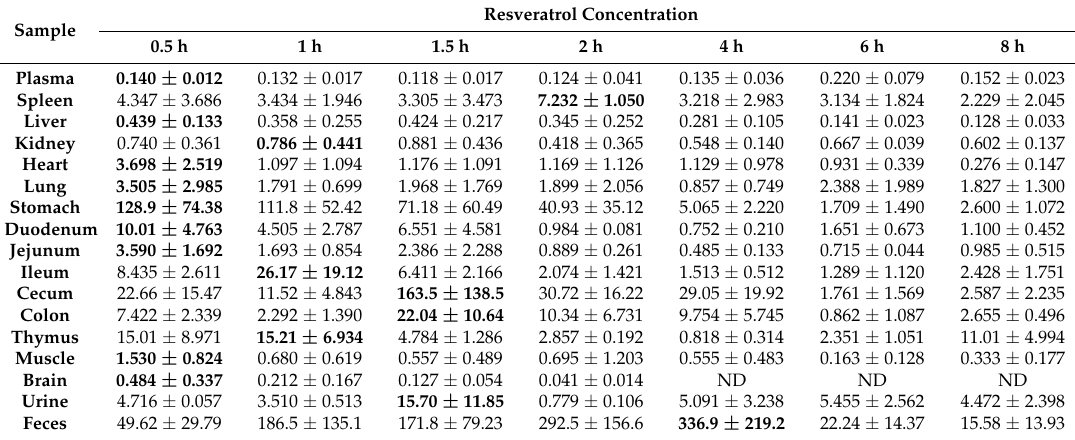
Table 1. Distribution of unmetabolized resveratrol in plasma (nmol/mL), various organs (nmol/g of tissue), urine (nmol/mL), and feces (nmol/g wet content) of mice at different time-points following the intragastric administration of a single dose of 10 mg/kg resveratrol. Maximum concentrations (C max values) are in bold.